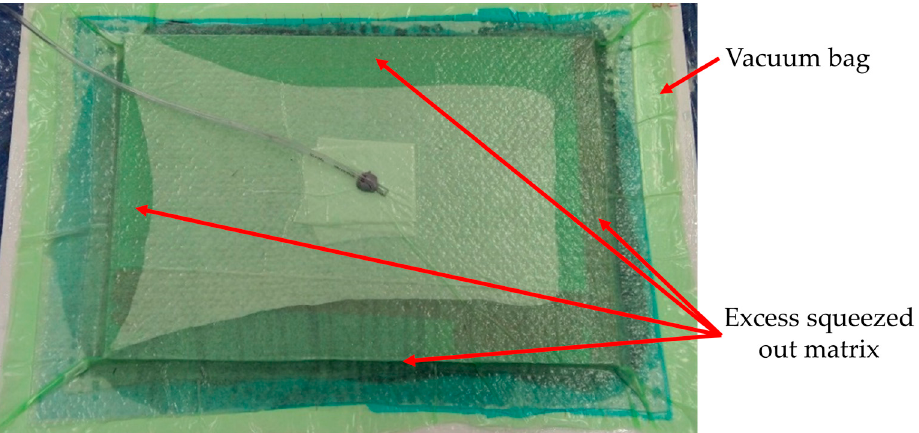
Figure 1. Squeezed out excess of the matrix during preparation of the composite by the vacuum supported hand laminating method.